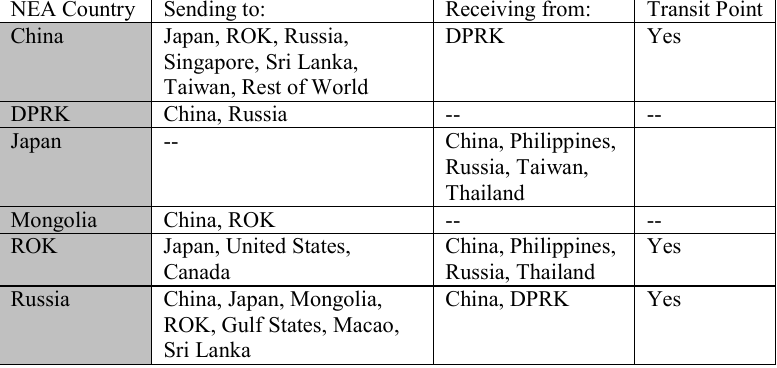
Table 1 : Human Trafficking Linkages in Northeast